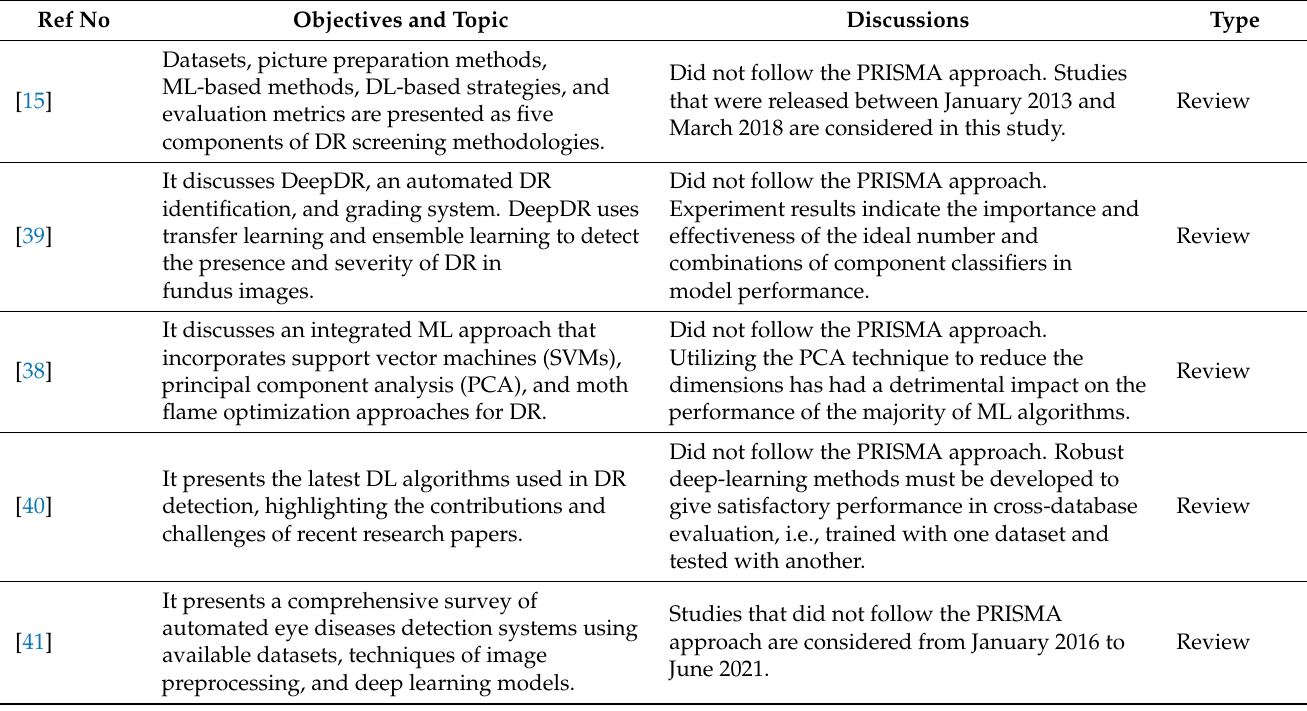
Table 1. Highlights of earlier research related to